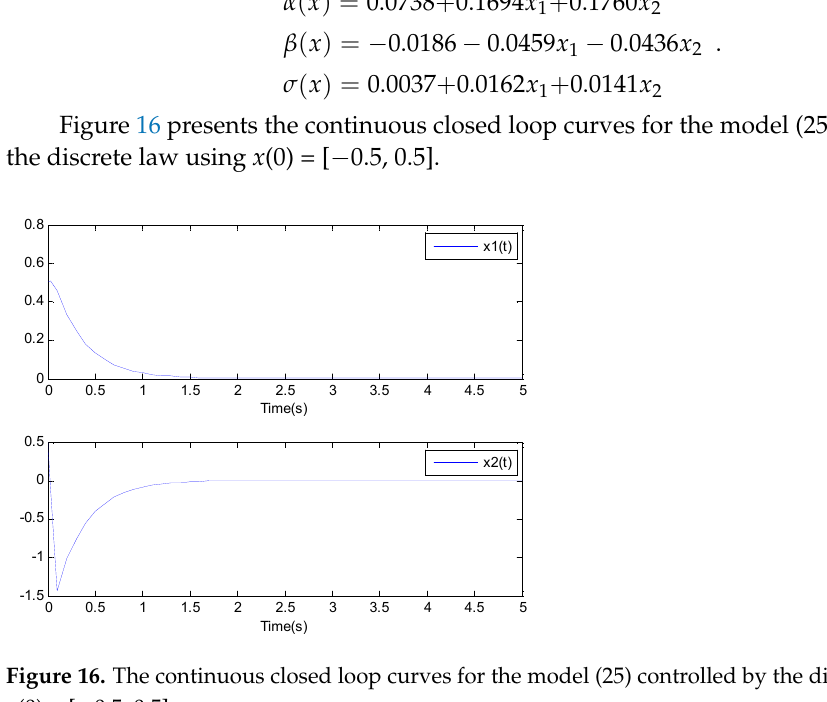
Figure 18. The state evolution